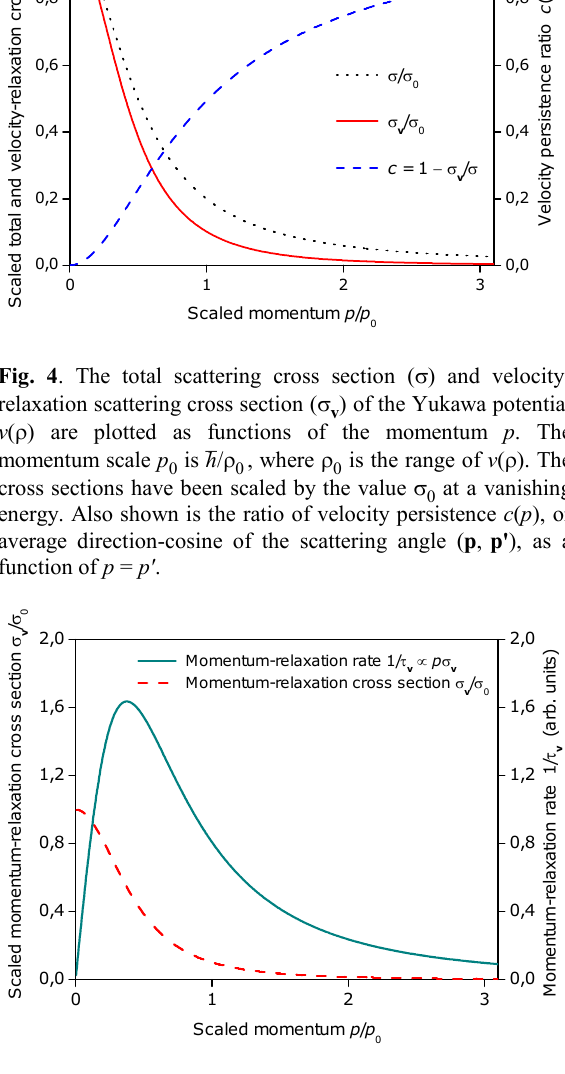
) is plotted as a v ) of the v